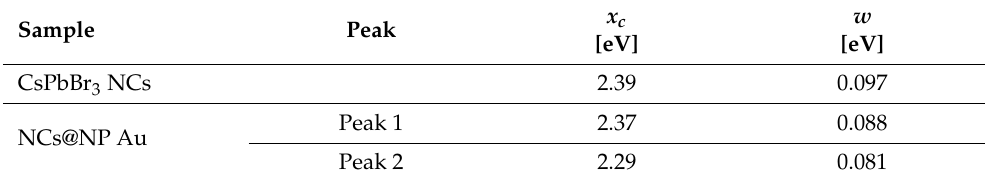
Table 3. Fit parameters of PL measurements on pure CsPbBr 3 NCs and the NCs-Au hybrid structure. Sample